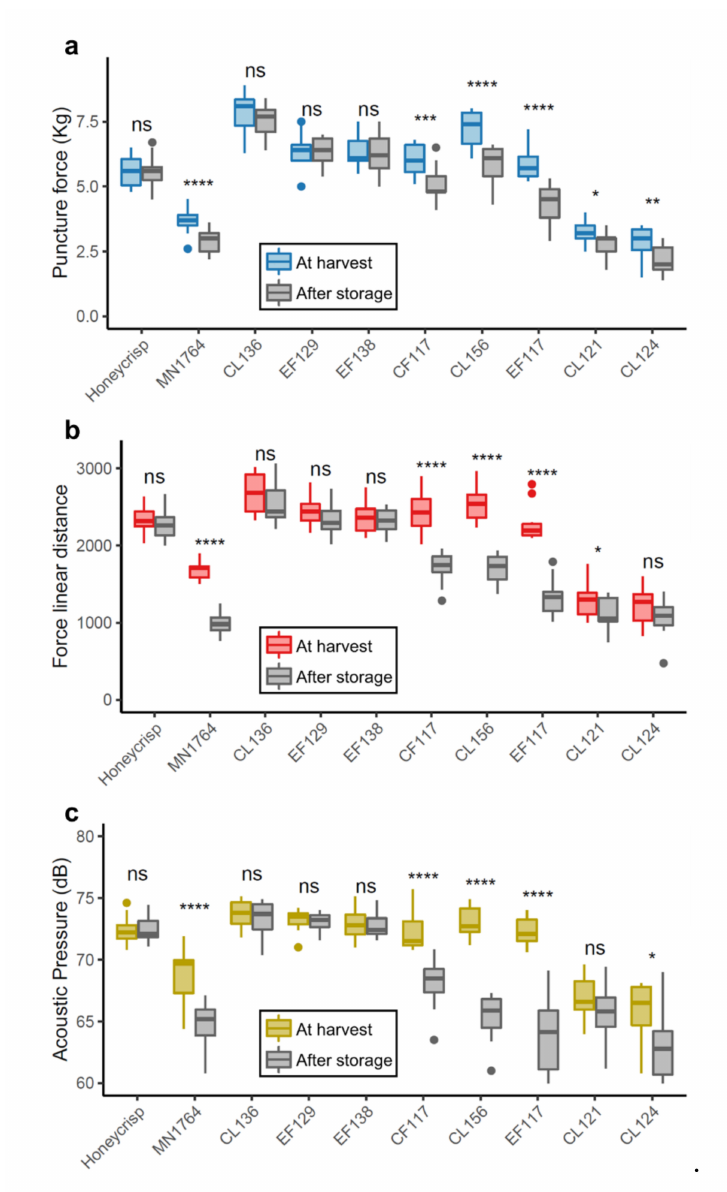
Figure 1. Three instrumental texture measures, including ( a ) puncture force, ( b ) force linear distance, and ( c ) acoustic pressure, of the parents (Honeycrisp and MN1764) and the progeny individuals at harvest and after 2-month cold storage. The results were obtained from three-year measurements (2016–2018). For each time point, five fruit were sampled from each parent and individual. The symbols indicate statistical significances between fresh and stored fruit of an individual: ns = not significant, * p < 0.05, ** p < 0.01, *** p < 0.001, **** p <